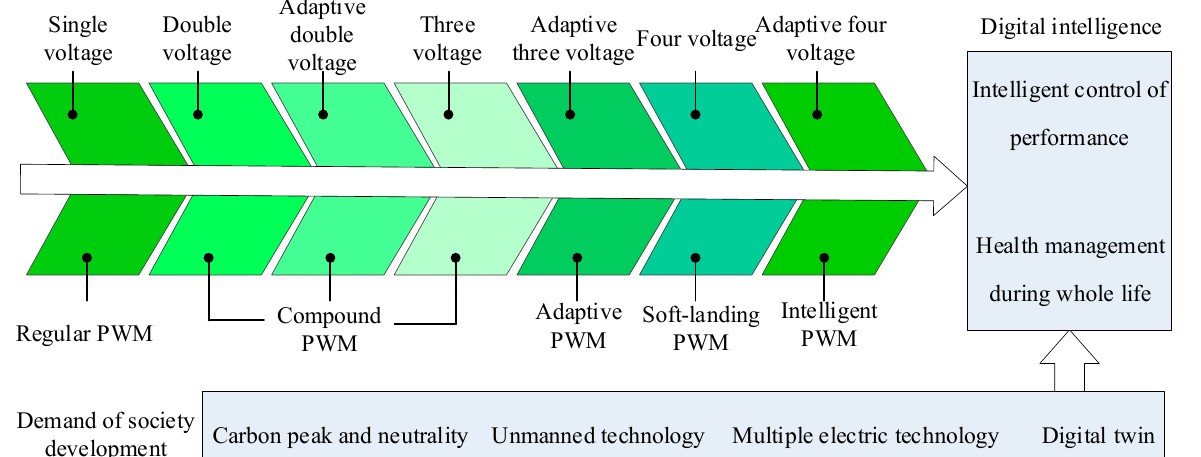
Figure 15. Development trends in control strategies for single valves.